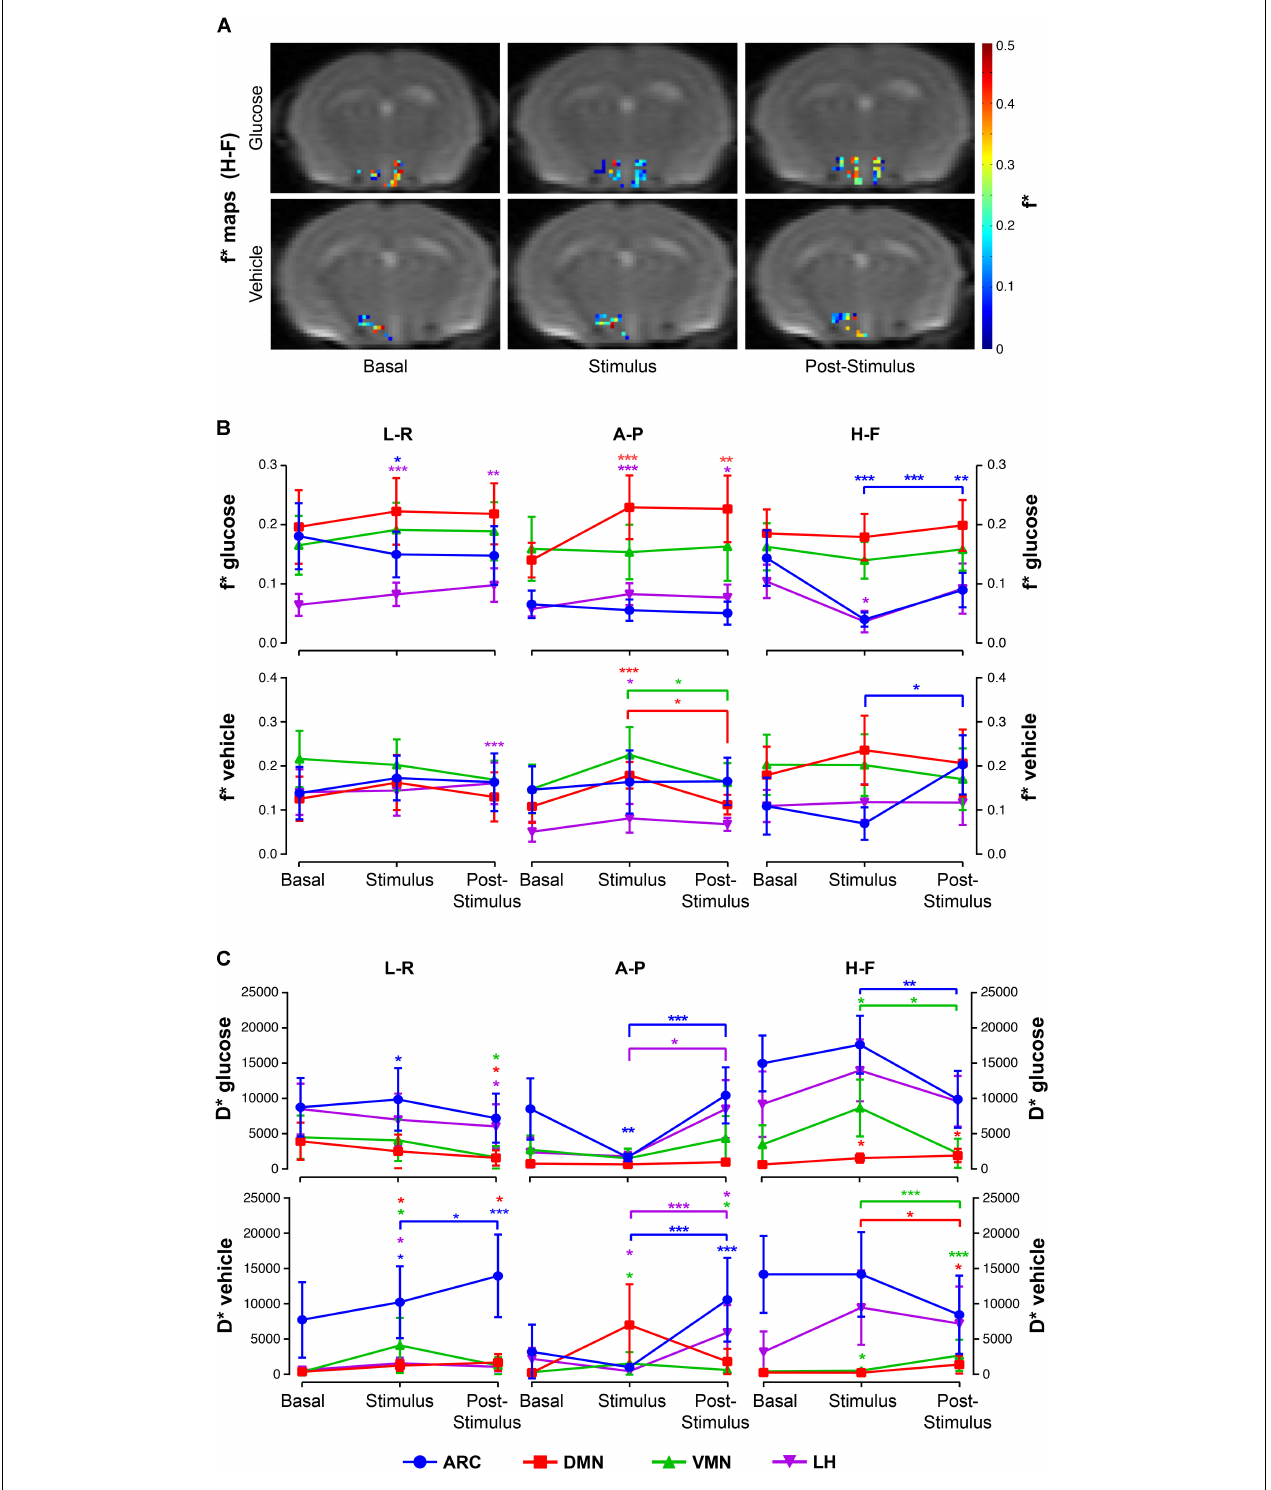
FIGURE 6 | Intravoxel incoherent motion (IVIM) alterations in hypothalamic nuclei after the administration of glucose or vehicle to fasting mice. (A) Hypothalamic f ∗ maps of representative mice receiving glucose (top) or vehicle (bottom) administrations, in the basal , stimulus and post-stimulus conditions. (B) Mean f ∗ voxel values ( ± SEM) from sub-hypothalamic nuclei of mice receiving glucose (top) or glucose administrations (bottom), and (C) Mean D ∗ ( ± SEM) coefficients of mice receiving the glucose solution (top) or vehicle (bottom) in the ARC, DMN, VMN and LH nuclei (in blue, red, green and purple, respectively) ( ∗ p < 0.05, ∗∗ p < 0.005, ∗∗∗ p < 0.001).